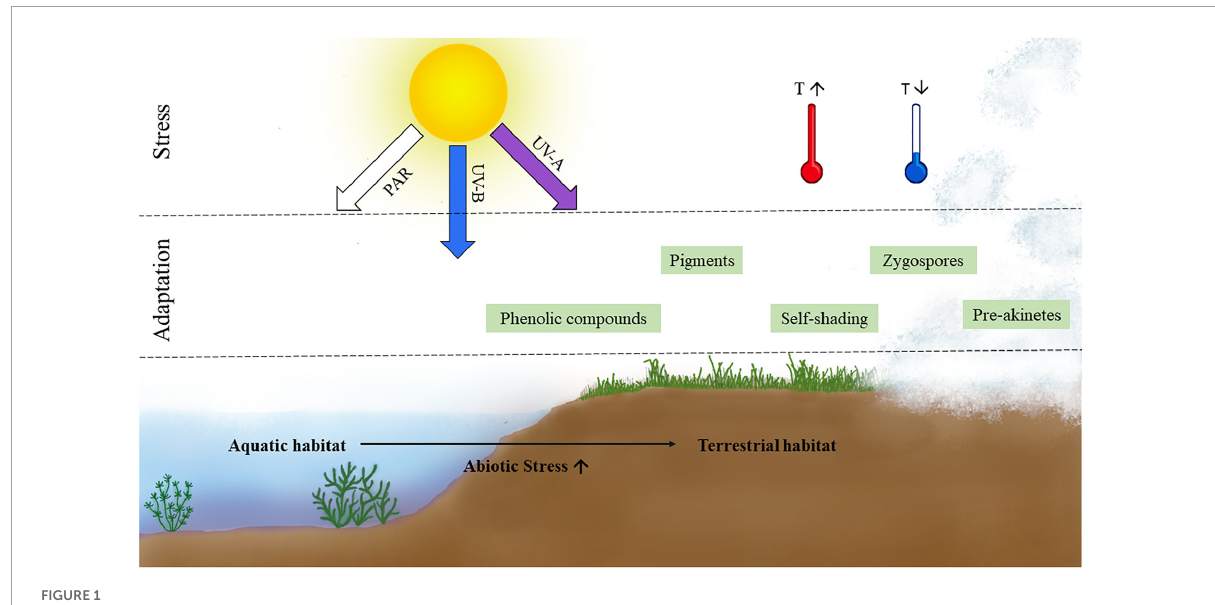
FIGURE1 Schematic representation of two major abiotic stresses accompanying terrestrial habitats and associated adaptation strategies of zygnematophycean green